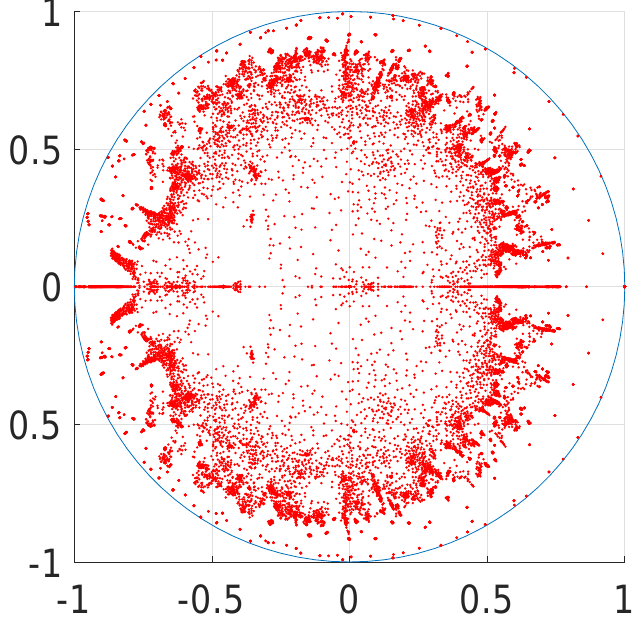
Figure 11. Eigenvalues distribution of the transmission MOT matrix in the complex plane for the case of the conductive